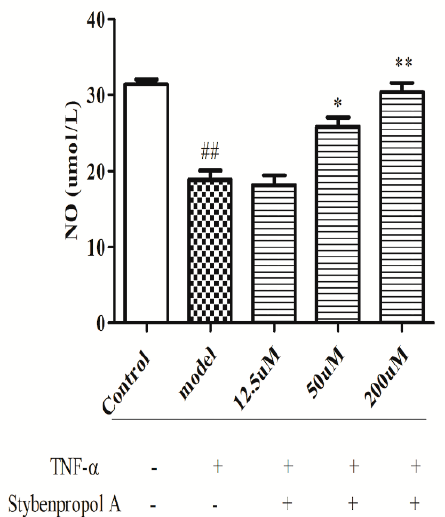
Figure 4. Effects of stybenpropol A on NO secretion in HUVECs treated by TNF- α . Following a 24-h pretreatment with stybenpropol A (12.5, 50, 200 µ M), HUVECs were treated with TNF- α and levels of NO was measured via a NO kit. Data are means ± SD of three independent experiments. ## p < 0.01 vs. control; ∗ p < 0.05, ∗∗ p < 0.01 vs. model